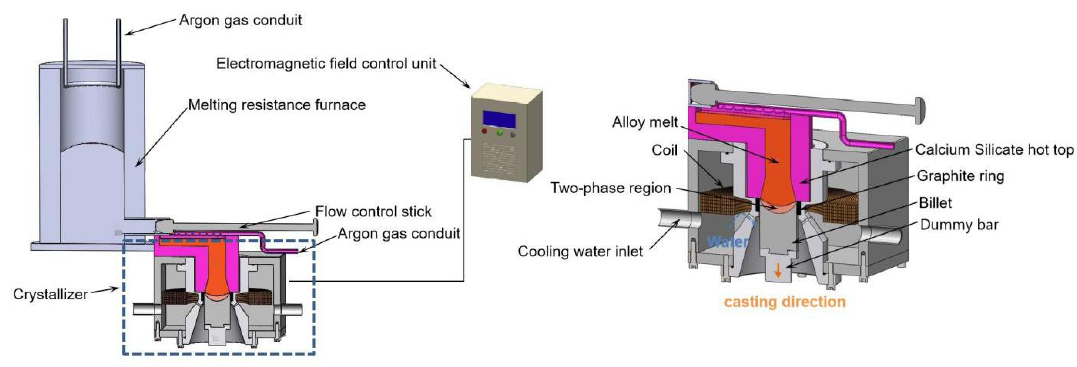
Figure 1. Schematic diagram of low-frequency electromagnetic casting process.